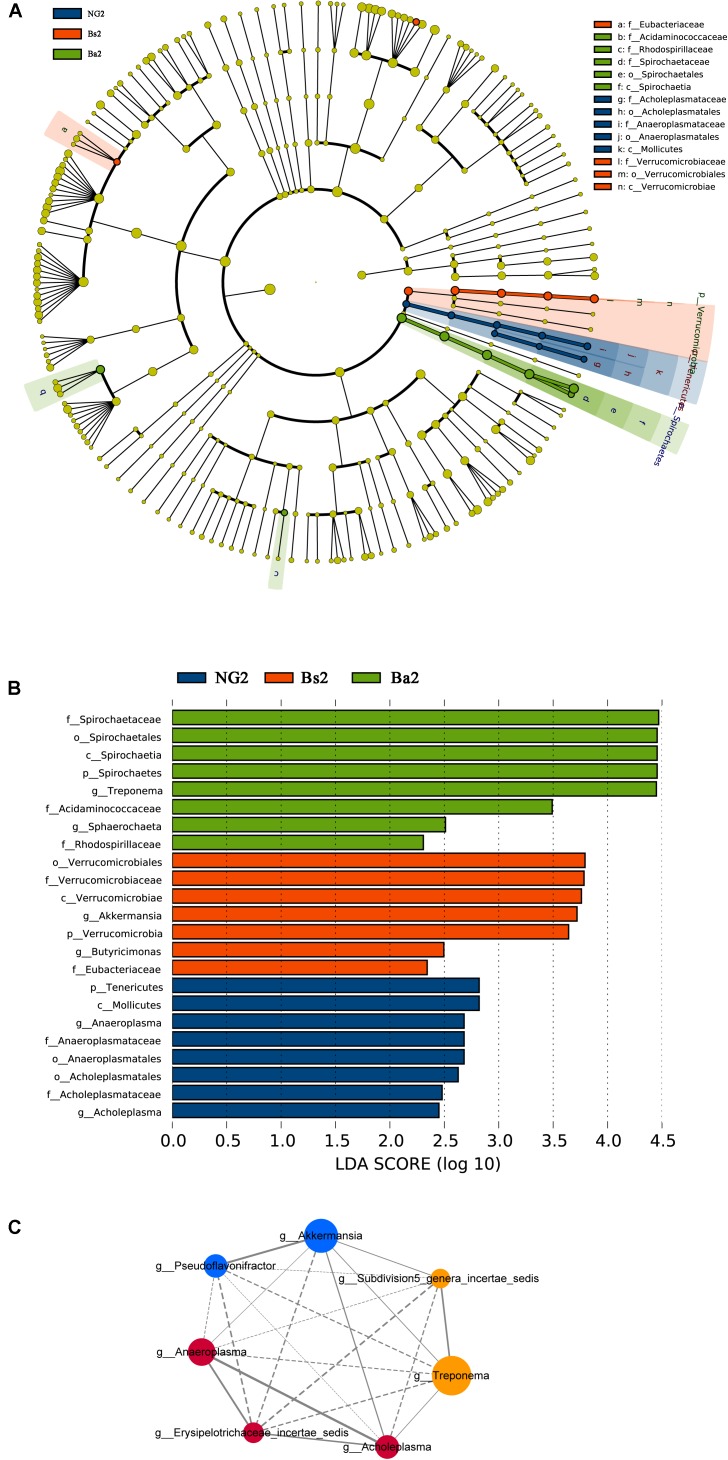
Bacterial taxa significantly differentiated (A,B) and Network analysis applied to the calf gut microbiota (C) among NG, Bs, and Ba groups post-intervention, identified by linear discriminant analysis coupled with effect size (LEfSe); for the network, node size is proportional to the genera abundance, node color corresponds to genera taxonomic classification (RED for NG, BLUE for Bs, and YELLOW for Ba group). Active line represents positive correlation and dotted line means negative correlation.